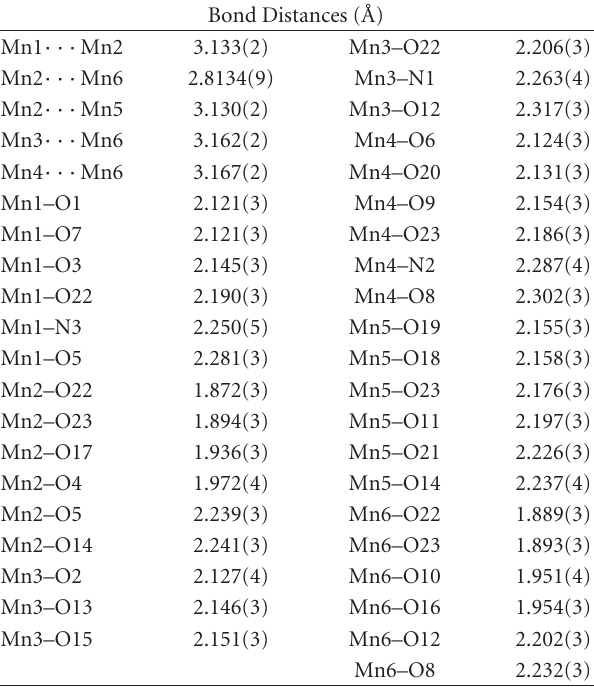
Table 3: Selected interatomic distances ( ˚A) for complex ( 2 ·